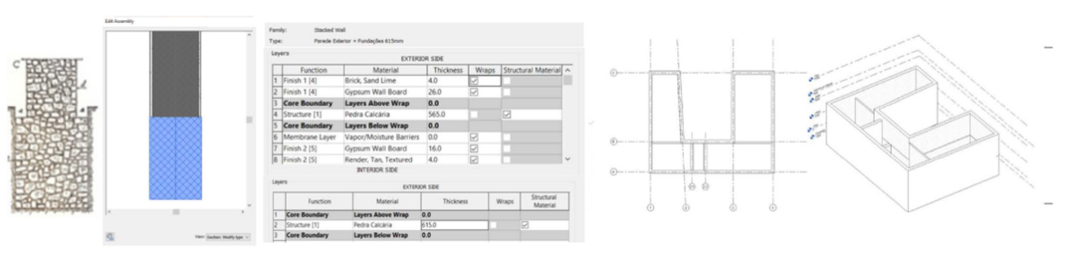
Figure 12. Generation of a parametric object representing a structural wall and its foundation.